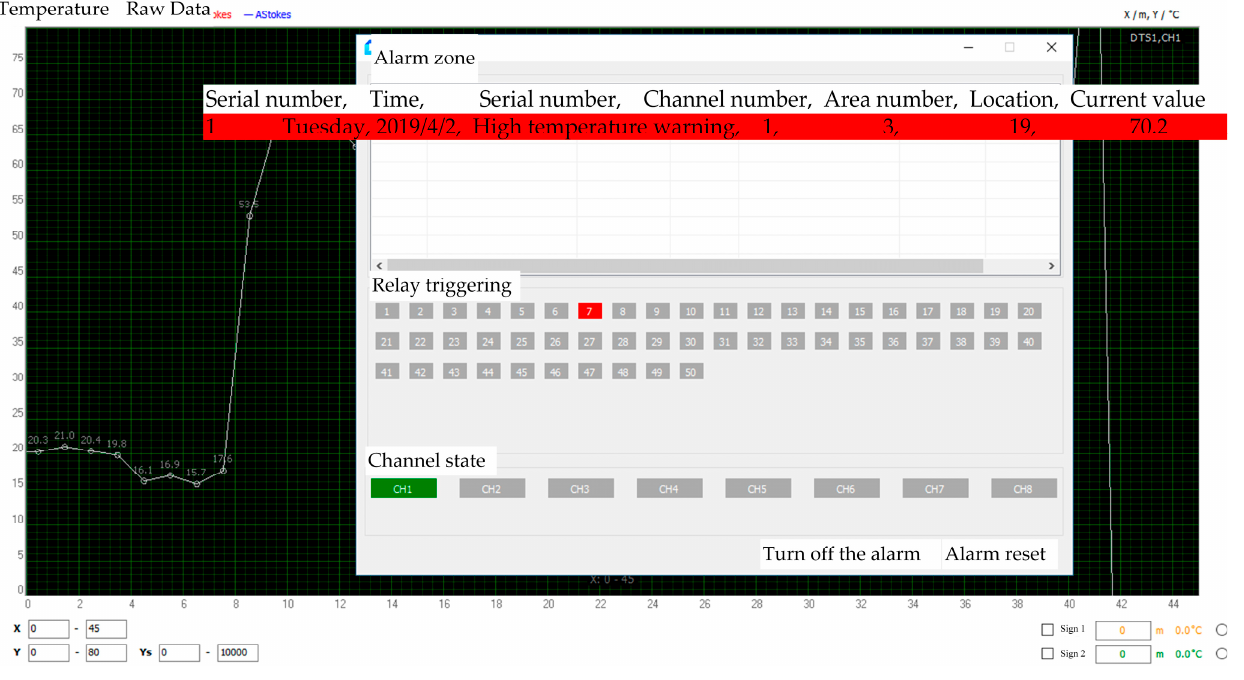
Figure 9. Interface image of DTS high-temperature alarm system.